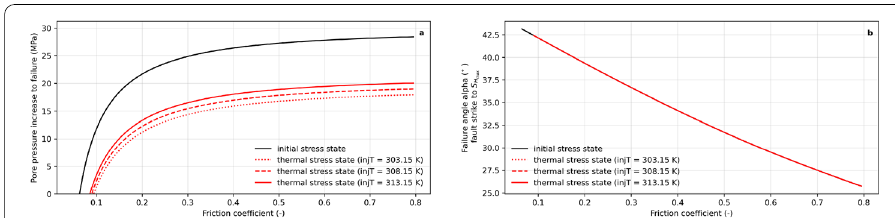
Fig. 11 Pore pressure required to reach failure along the σ 2 – σ 3 plane for the initial stress state and the thermal stress states considered for a range of friction coefficients ( a ). The critical fault strike angle with respect to S H for the different stress states for the range of friction coefficients ( b max